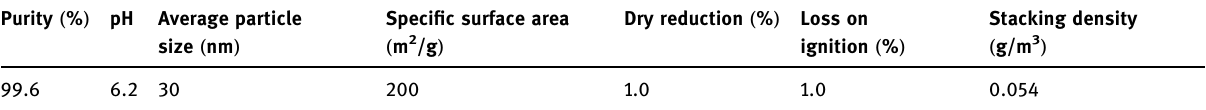
Table 3: Properties of NS